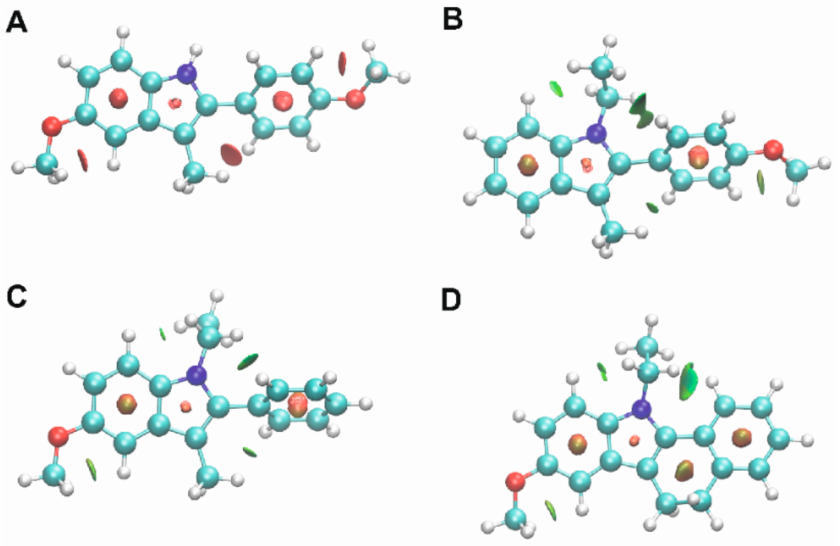
Figure 12. Non-covalent interactions for compounds 1 ( A ), 2 ( B ), 3 ( C ) and 4 ( D ). Green colour denotes weak attractive interactions, while red indicates strong and repulsive